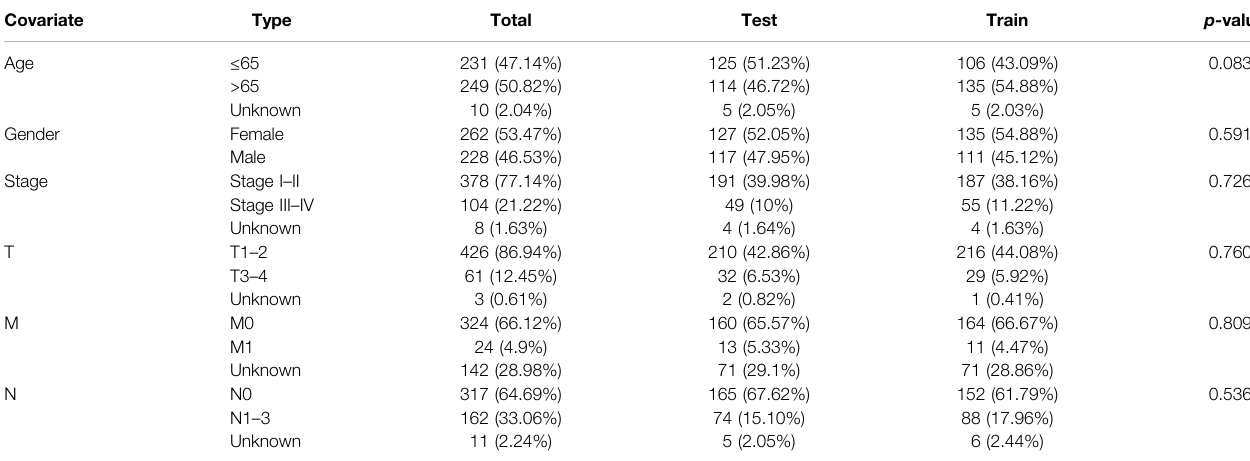
TABLE 1 | Clinical details of 490 LUAD patients.